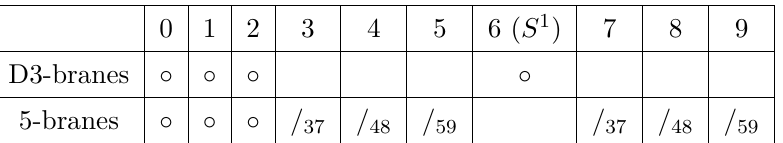
Table 1 . The ingredients of the type IIB brane configuration studied in this paper. The 6th direction is taken to be a small circle. The symbol “ / ” for 5-branes means that the 5-branes are ij oblique in the ( x ) plane with appropriate angles dependent on ( ‘, k ) . i , x j